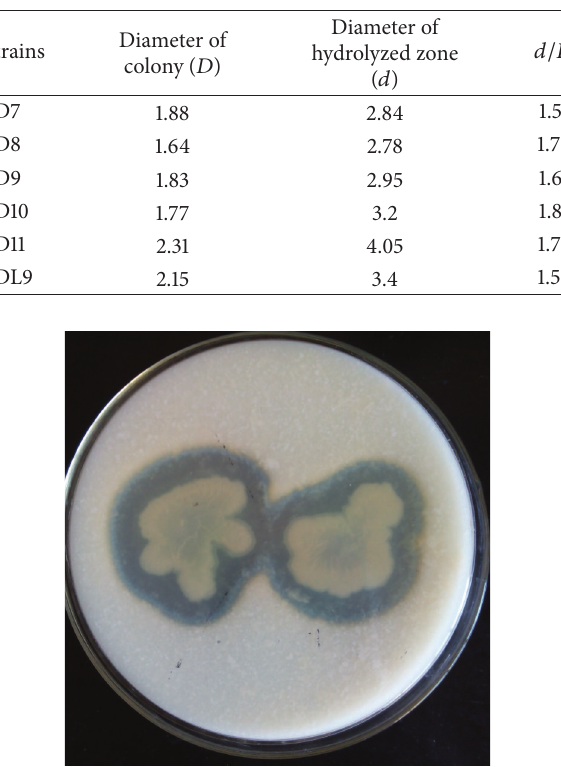
Table 1: The diameter of colony and hydrolyzed zone.